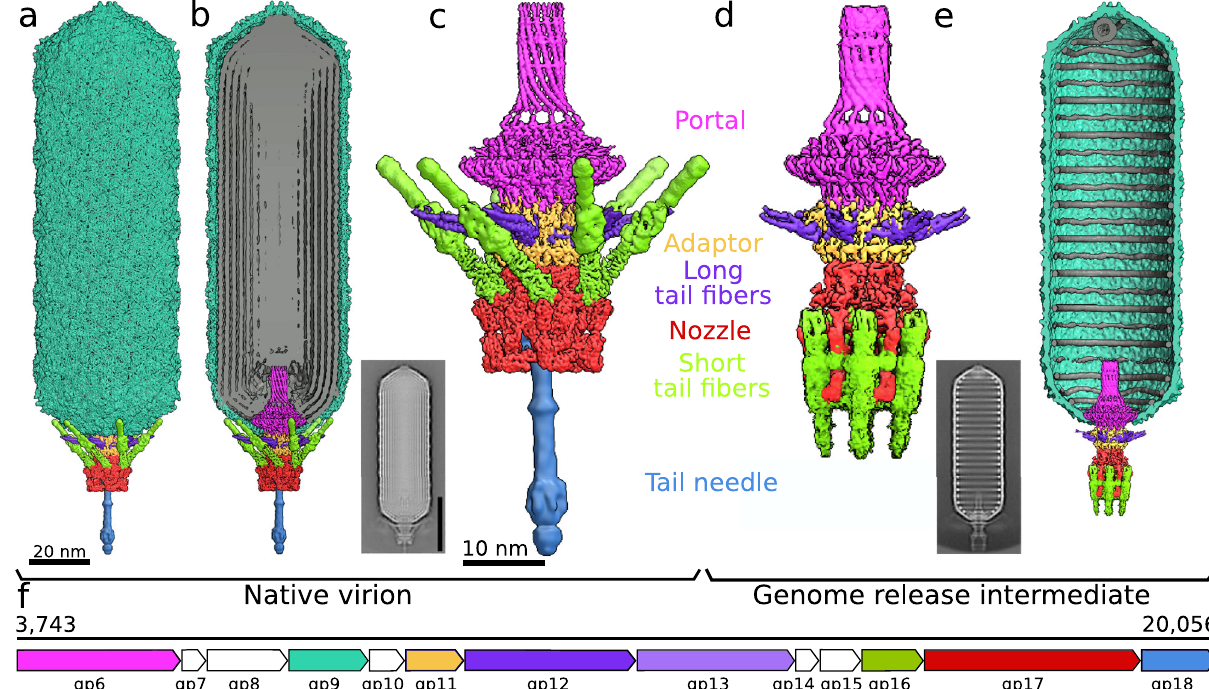
Fig. 1 | Structure of virion and genome-release intermediate of phage SU10. a Surface representation of composite cryo-EM map of virion of phage SU10 colored according to protein type. The major capsid protein (gp9) is shown in turquoise, portal protein (gp6) in magenta, adaptor protein (gp11) in yellow, long tail fi bers (gp12) in violet, nozzle protein (gp17) in red, short tail fi bers (gp16) in green, and tail needle (gp18) in light blue. The length of the virion is 1590Å. For details on the construction of the composite map, please see the Materials and methods section. b The same as A, but the front half of the composite map of the SU10 head was removed to show the structure of the genome in grey. The inset shows a 2D class average of the SU10 virion. The scale bar indicates